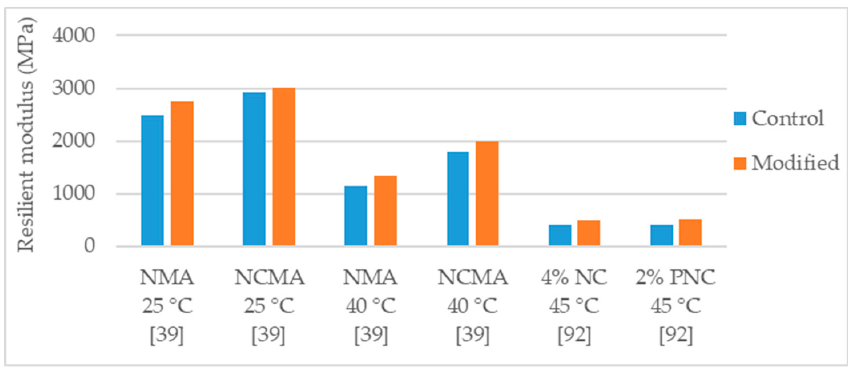
Figure 12. Resilient modulus of control and nanoclay modified asphalt mixtures.